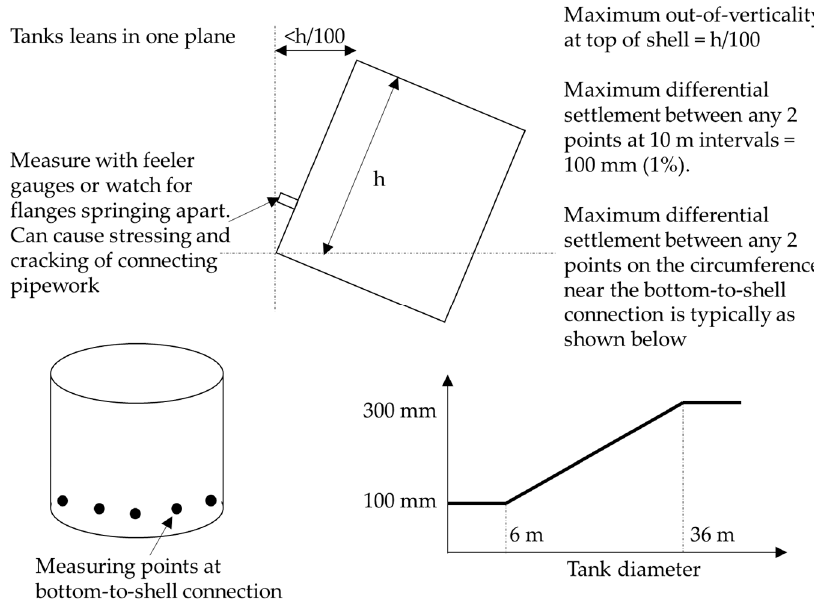
Figure 9. Planar tilt of storage tanks. Adapted from [18].